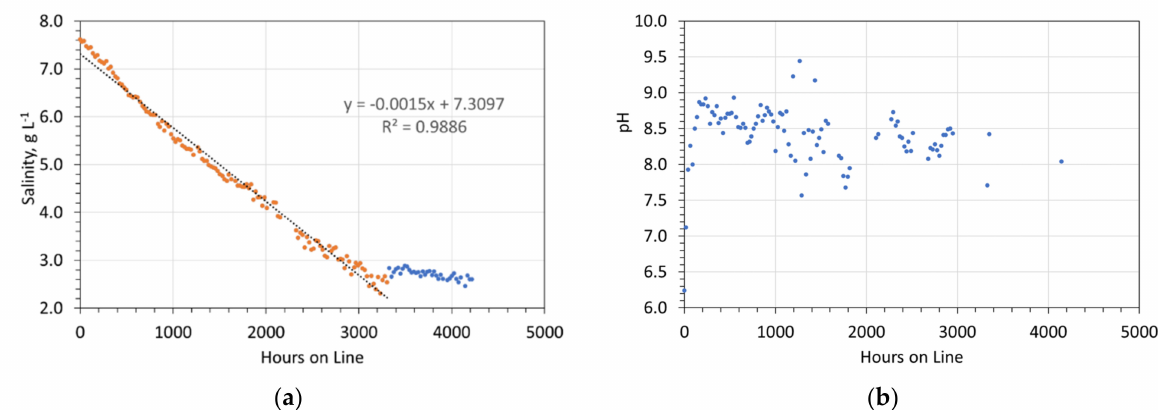
Figure 12. Example of desalination using a desalination pellet. Note a linear reduction in salinity with time (brown dots) followed by a period with no salinity change (blue dots). Reaction Details: 5 pellets containing 27.12 g desalination catalyst, produced using 40 g NaCl L − 1 in the ZVI Reactor; Feed water salinity = 7.6 g NaCl L − 1 ; Reactor size 1 L; temperature range during operation = 0 to 14 ◦ C. ( a ) Salinity vs. Hours on line; ( b ) pH vs. Hours on